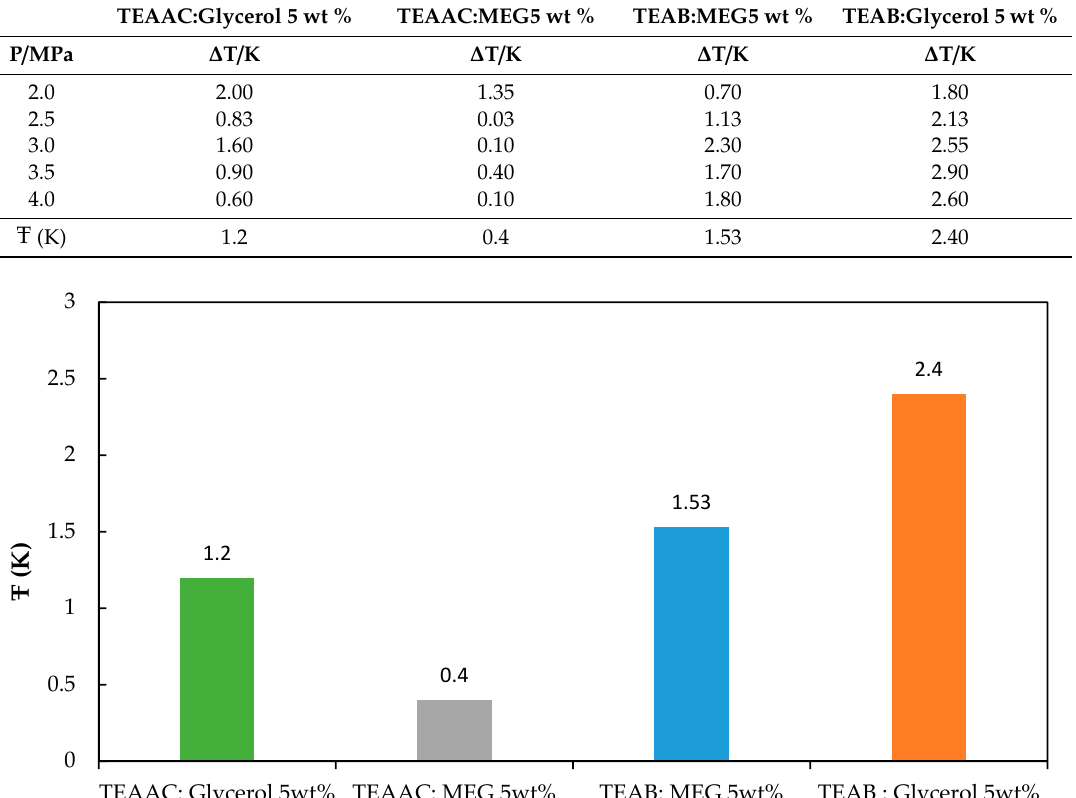
Figure 10. The average suppression temperature of the studied DESs.